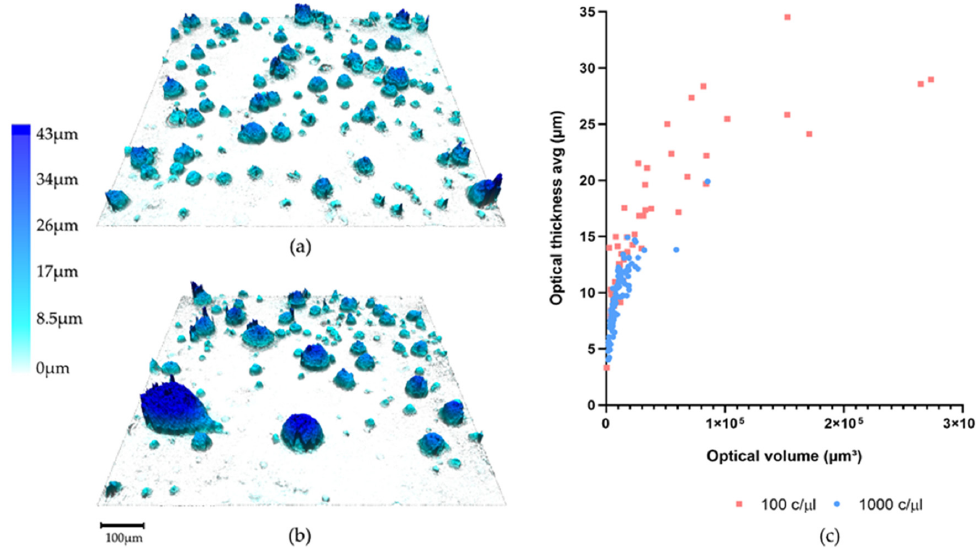
Figure 1. Seeding-density conditions and optical properties of organoids imaged with HoloMonitor M4. Oropharyngeal squamous-cell carcinoma (OPSCC) cells imaged 15 h after seeding at densities of ( a ) 100 and ( b ) 1000 cells/µl, both obtained by digital holographic microscopy (DHM). ( c ) Scatter plot displaying optical volume and thickness of organoids obtained using seeding densities of 100 and 1000 cells/µl ( n = 3).